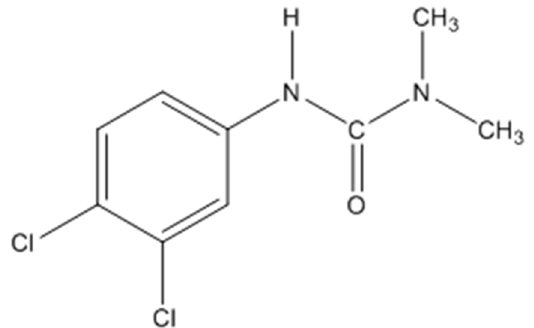
Figure 1. Structure of diuron.